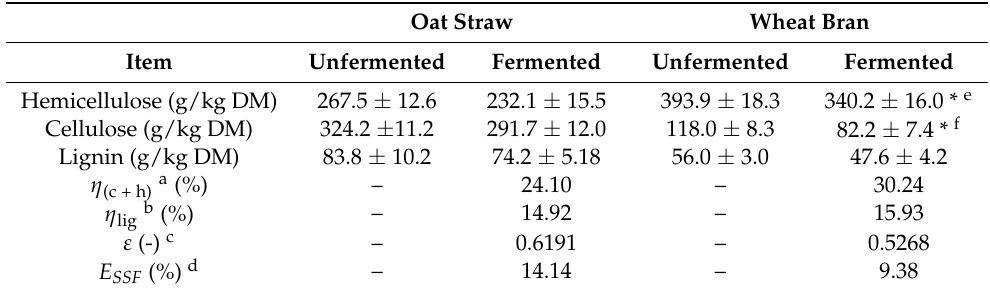
ε (-) c – E SSF (%) d – 14.14 –